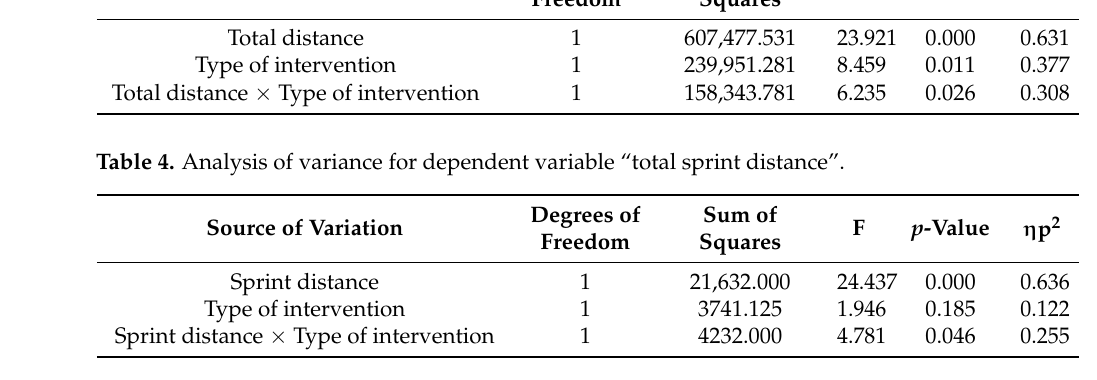
Table 5. Analysis of variance for dependent variable “aerobic